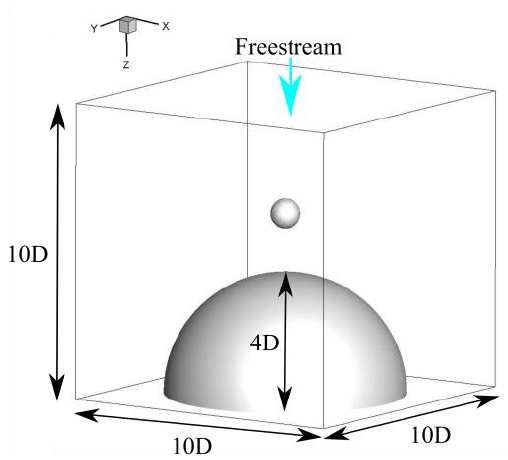
Figure 12. Computational domain of a particle (small sphere) colliding with a curved wall.